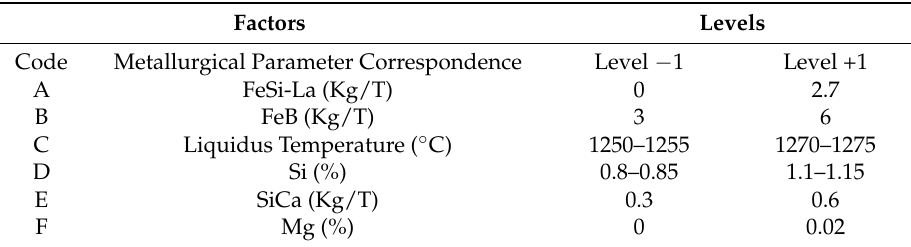
Table 3. Description of the Factors and Levels for the DoE.